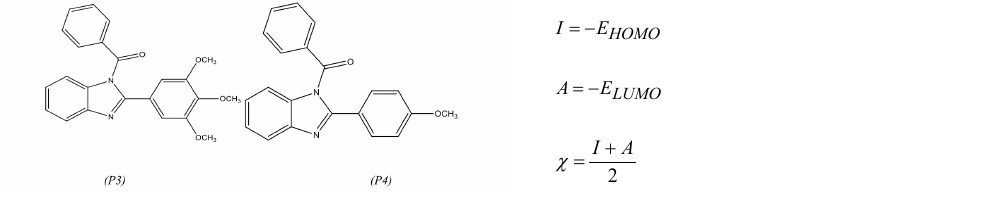
Figure 1. Molecular structure of phenyl (2-(3,4,5-trimethoxyphenyl)- 1H-benzo[d]imidazol-1-yl) methanone (P3) and (2-(4-methoxyphenyl)-